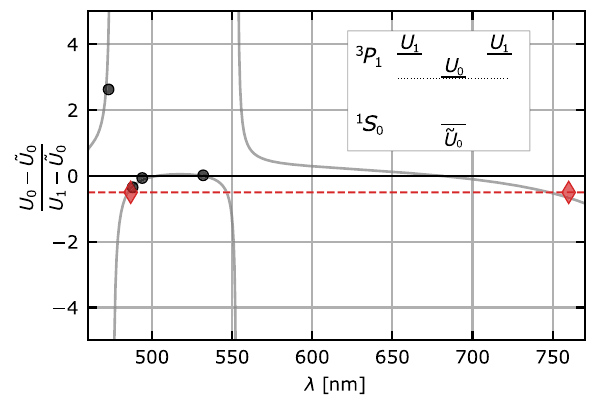
FIG. 6. Ratio of the differential light shifts for the 1 S 0 - 3 P 1 0 ( Δ U − ˜ U transition in 174 Yb, for the m 0 ¼ U 0 0 ) and J 0 ¼ ˜ U j m J 0 j ¼ 1 ( Δ U 1 ¼ U 1 − 0 ) transitions. The black points show measurements from 174 Yb, while the red points show inferred values from measurements with 171 Yb. A magic wavelength for 1 = 2 transition occurs when the 171 Yb 1 S 0 - 3 P 1 F 0 ¼ 3 = 2 ; j m F 0 j ¼ Δ U − 1 = 2 (dashed red line), which we confirm in 171 Yb Δ U 0 = 1 ¼ at 486.78 nm and near 759 nm. The gray line is an approximate model to guide the eye. Inset: level diagram indicating the light shift on each state in 174